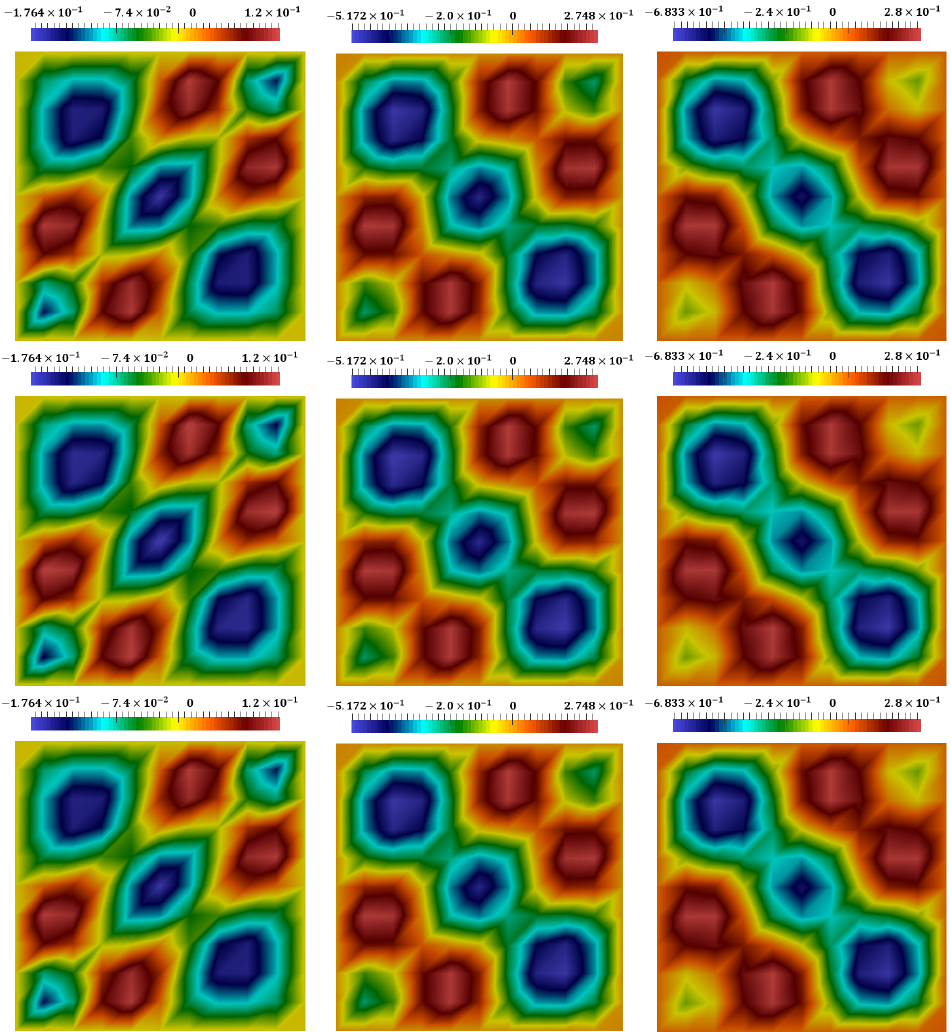
Figure 6. Distribution of pressure for the second continuum at different times, t m with m = 0.4,0.8,1 (from left to right ). ( The first row ): the coupled explicit–implicit solution. ( The second row ): the split explicit–implicit solution. ( The third row ): the proposed approach’s